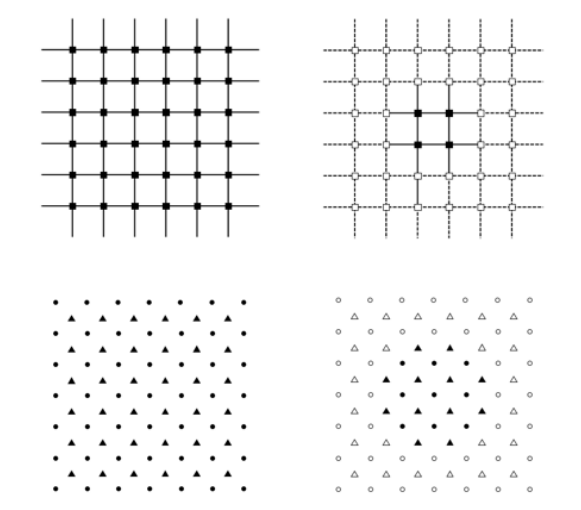
Figure 13 . The duality of gauge (cid:12)elds with matter on the lattice. The (cid:12)gures are corresponding to square regions of size n = 5. The top two (cid:12)gures correspond to the gauge (cid:12)eld and matter (cid:12)eld, while the bottom ones to the dual scalar (cid:12)elds representation of the same algebra. Links with solid lines mean both the operators ~ A and (cid:25) on the link belong to the algebra. Links with dashed lines mean the corresponding operator ~ A or (cid:25) does not belong to the algebra. Marked boxes correspond to both the matter (cid:12)eld operators ~ (cid:27) and (cid:25) (cid:27) . Marked dots correspond to both the scalar (cid:12)eld operators ~ (cid:31) and the momentum operator _ (cid:31) . Circle dots mean the scalar (cid:12)eld operator ~ (cid:31) or operator _ (cid:31) does not belong to the algebra. Marked triangles correspond to both the scalar (cid:12)eld operators ~ (cid:30) and the momentum operator _ (cid:30) . Unmarked triangles mean the scalar (cid:12)eld operator ~ (cid:30) or the momentum operator _ (cid:30) does not belong to the algebra. Because of the constraints of gauge (cid:12)eld and matter (cid:12)eld, we (cid:12)x the matter (cid:12)eld to remove the redundant degrees of freedom. The gauge (cid:12)eld operators correspond to the physical degrees of freedom. The left panel shows the trivial center choice, while the right panel is related to the ~ A center or (cid:25) center choice (not exactly), according to the meaning of dashed